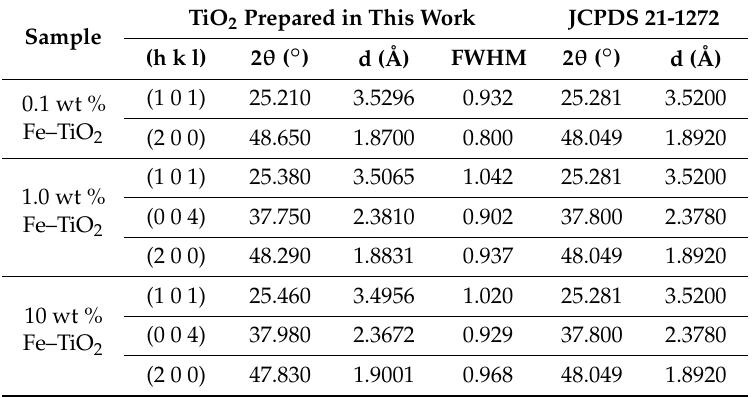
Table 2. Parameters of the diffraction peaks of TCF with different Fe 3+